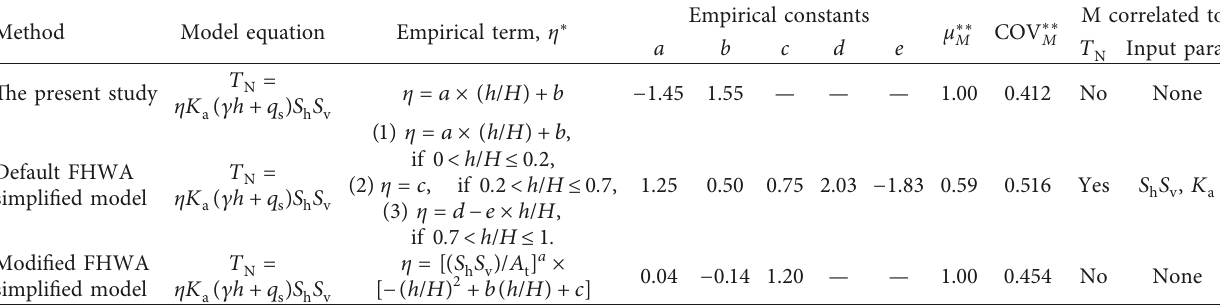
Table 4: Comparisons of model accuracy in estimation of maximum nail loads among different models.